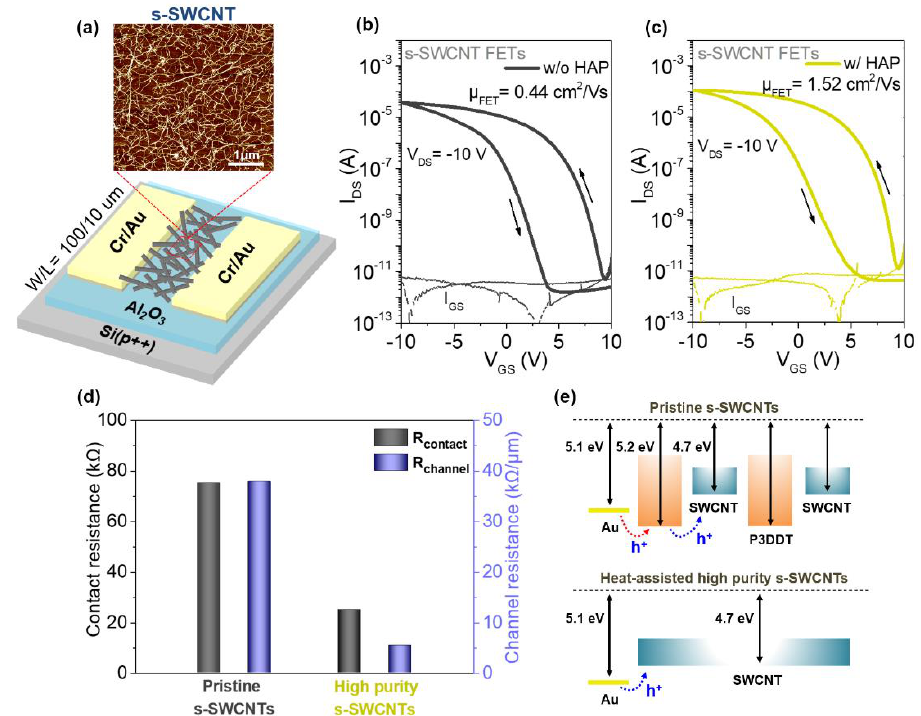
Figure 2. ( a ) A schematic of the SWCNT FET device and an AFM image of the s-SWCNT network. The transfer characteristics of the SWCNT FETs ( b ) without and ( c ) with the HAP process, respectively (W/L = 100/10 µ m, V DS = − 10 V). ( d ) Comparison of contact and channel resistance for the pristine (w/o the HAP) and high-purity s-SWCNT FETs. ( e ) Energy band diagrams of the s-SWCNT